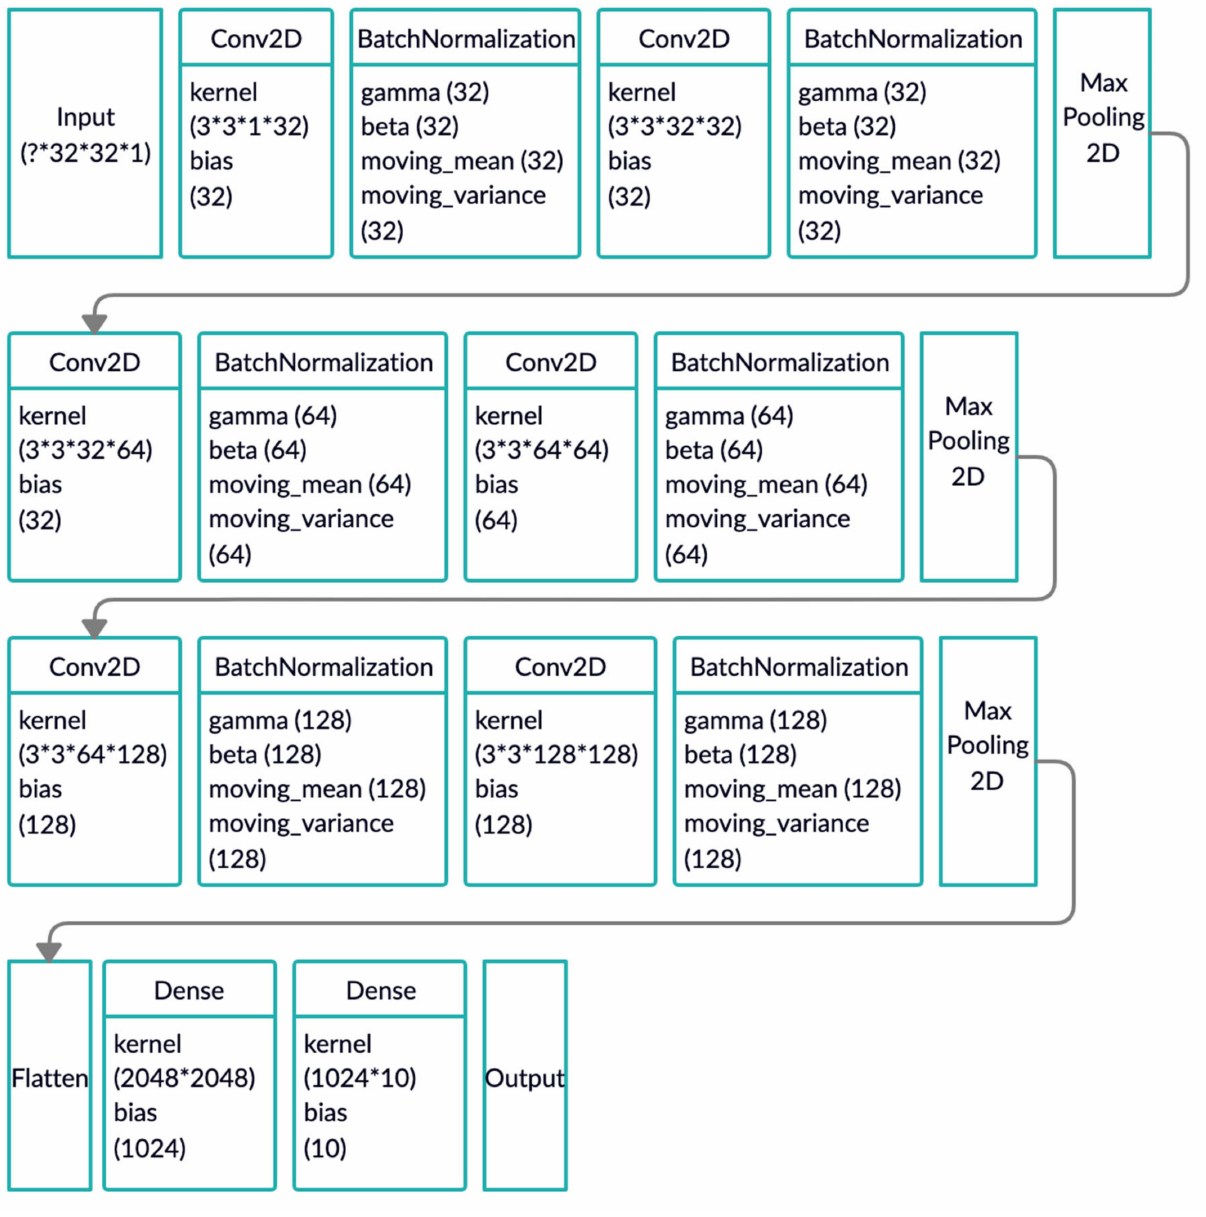
Figure 6. Model structure corresponding to the advanced CNN model implemented in the current study (see code in the Appendix